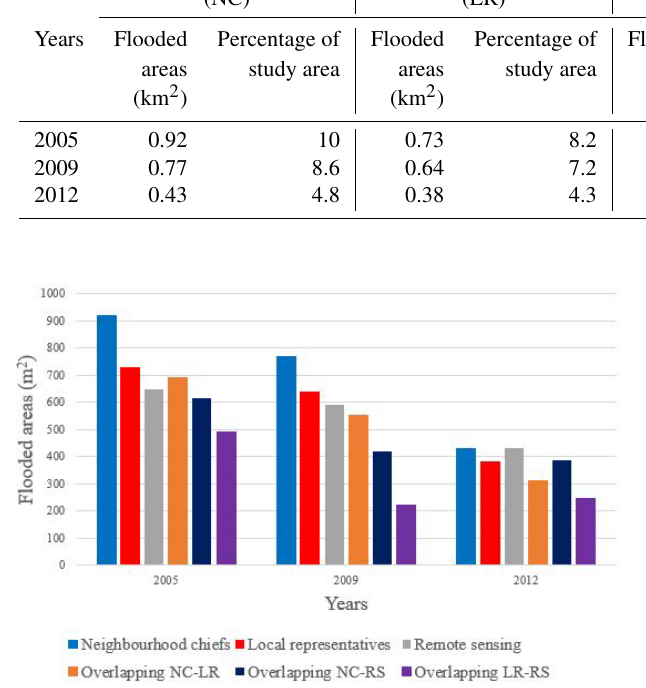
Figure 5. Flooded areas obtained by the two citizen groups and remote sensing with the surface of overlapping areas between the two results of the citizen groups (orange), neighbourhood chiefs and remote sensing (dark blue), and local representatives and remote sensing (purple).